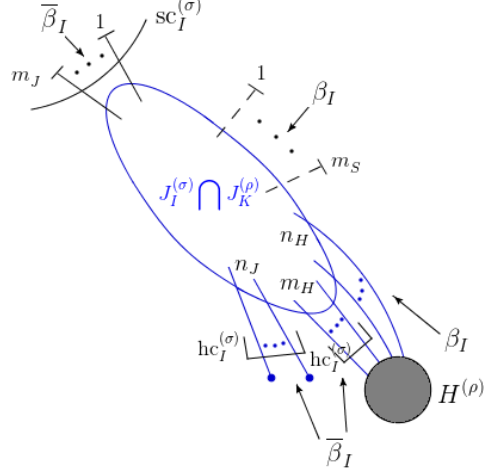
T J ( (cid:26) ) in (cid:26) , which includes all the blue lines. There are I K + m ) internal lines whose J H , and the black subgraph is H ( (cid:26) ) I